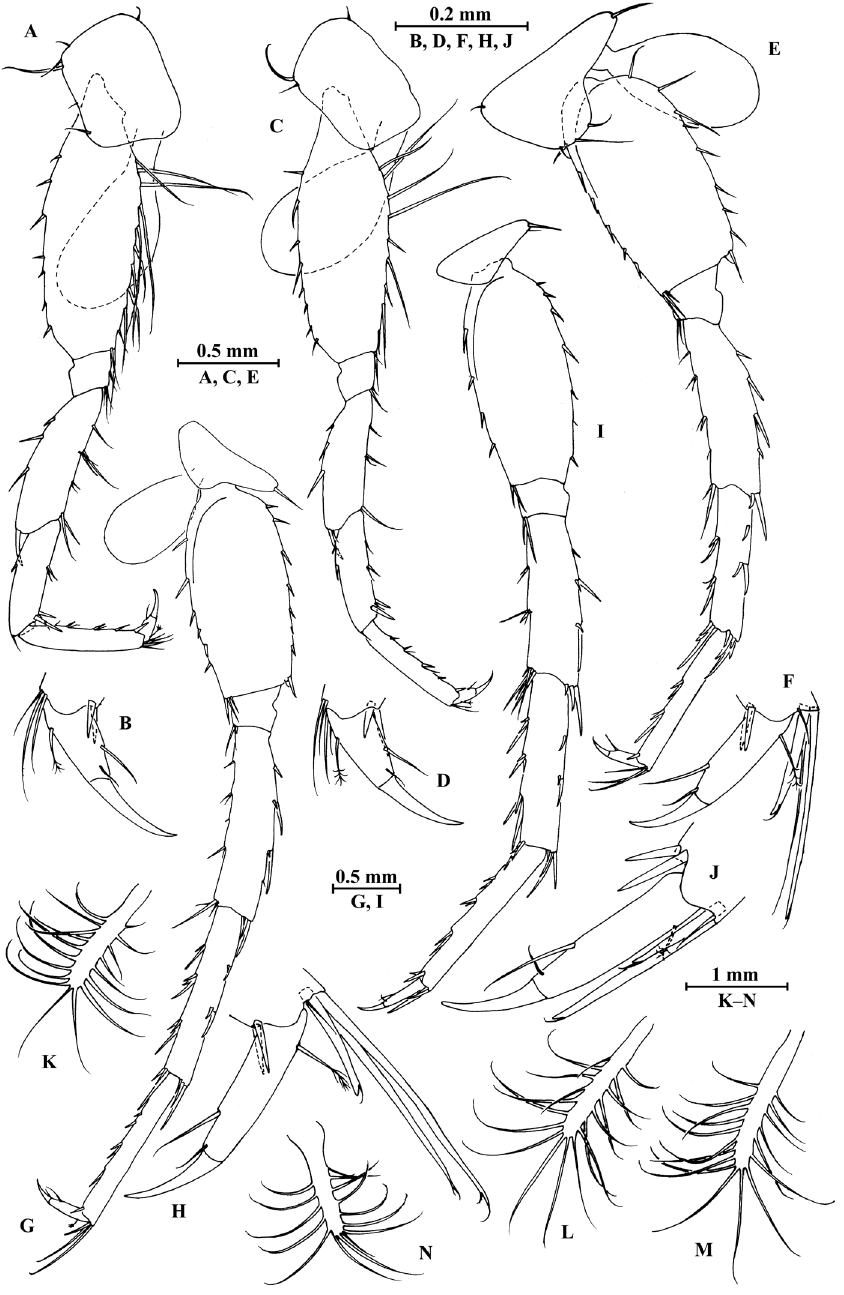
Figure 4. Pseudocrangonyx elegantulus sp. n., female holotype. A pereopod III B dactylus of pereopod III C pereopod IV D dactylus of pereopod IV E pereopod V F dactylus of pereopod V G pereopod VI H dactylus of pereopod VI I pereopod VII J dactylus of pereopod VII K oostegite of gnathopod II L oost- egite of pereopod III M oostegite of pereopod IV N oostegite of pereopod